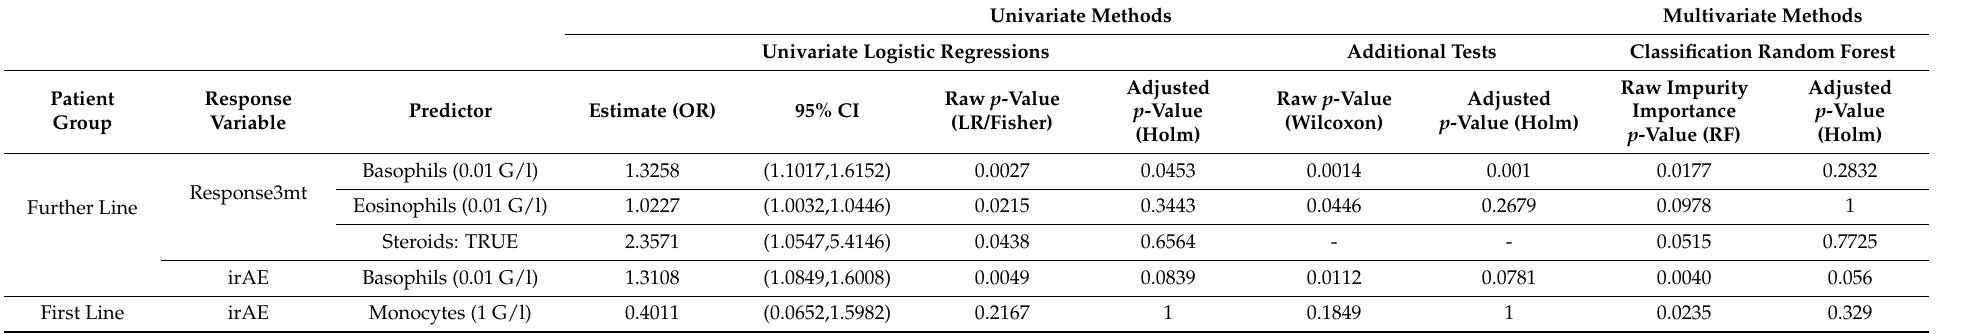
Table 2. Significant results for response at three months and development of immune-related adverse events for the first- and further-line patient groups (complete list of results is presented in Tables S3–S6).